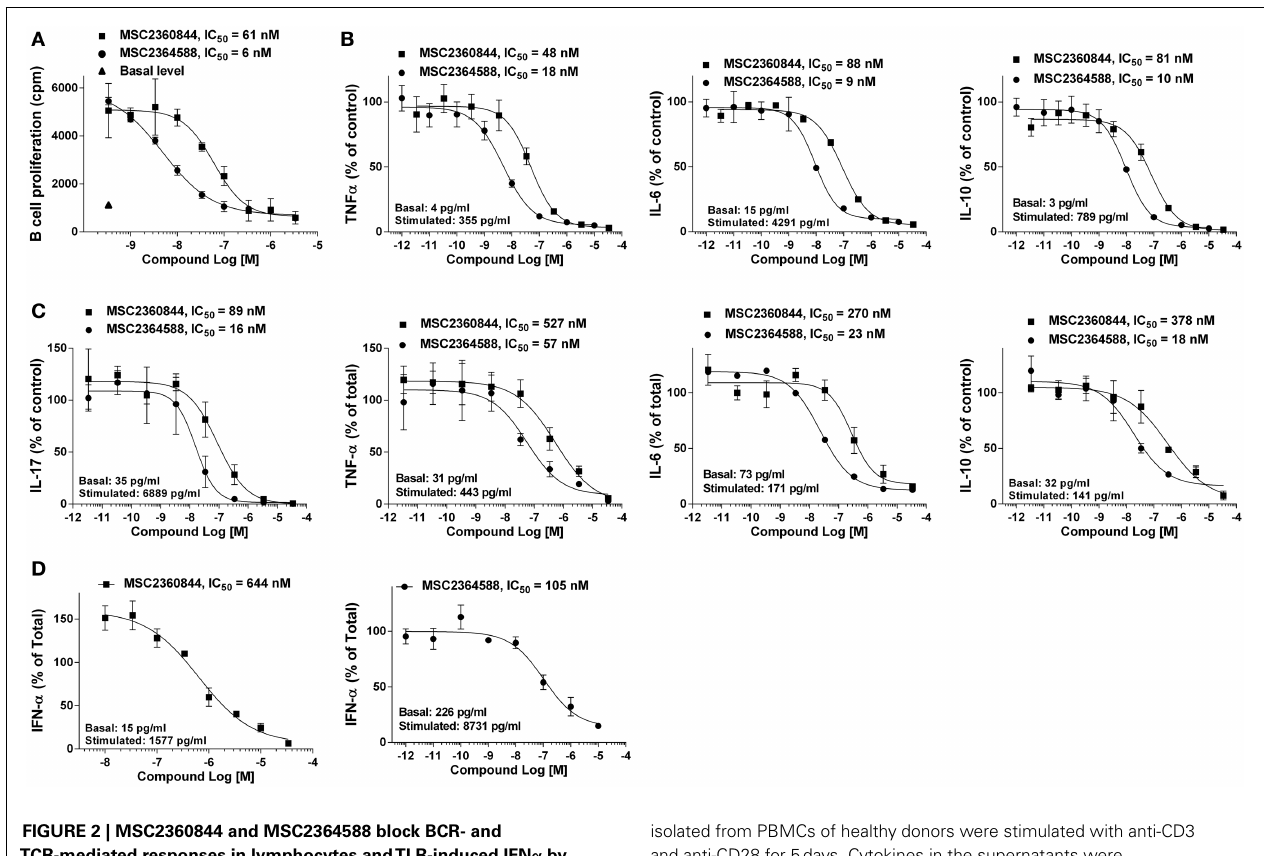
FIGURE 2 | MSC2360844 and MSC2364588 block BCR- and TCR-mediated responses in lymphocytes andTLR-induced IFN α by pDC in human primary cells . (A) CD19 + B cells isolated from PBMCs of healthy donors were stimulated with anti-IgM and IL-4 for 4days. Proliferation was measured by [ 3 H]-thymidine incorporation. (B) CD19 + B cells isolated from PBMCs of healthy donors were stimulated with anti-Ig, CpG ODN 2006, and IFN α for 48h. Cytokines in the supernatants were measured with CBA kits. (C) CD4 + CD45RA − T-cells